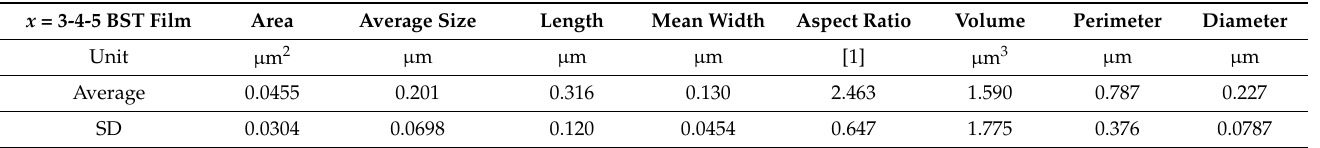
Table 6. Parameters of the grain analysis of the “downgraded” ( x = 3-4-5) BST thin films deposited on stainless-steel